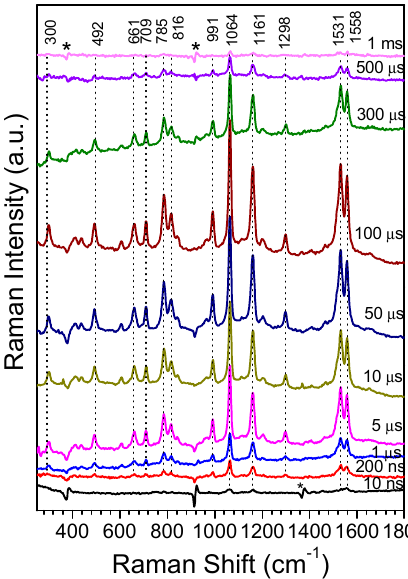
Figure 4. Shown are the ns-TR 3 spectra using a 341.5 nm probe wavelength for intermediates formed after 266 nm photoexcitation of DN in a 1:1 MeCN:H 2 O. The star symbols mark places influenced by solvent subtraction artifacts.